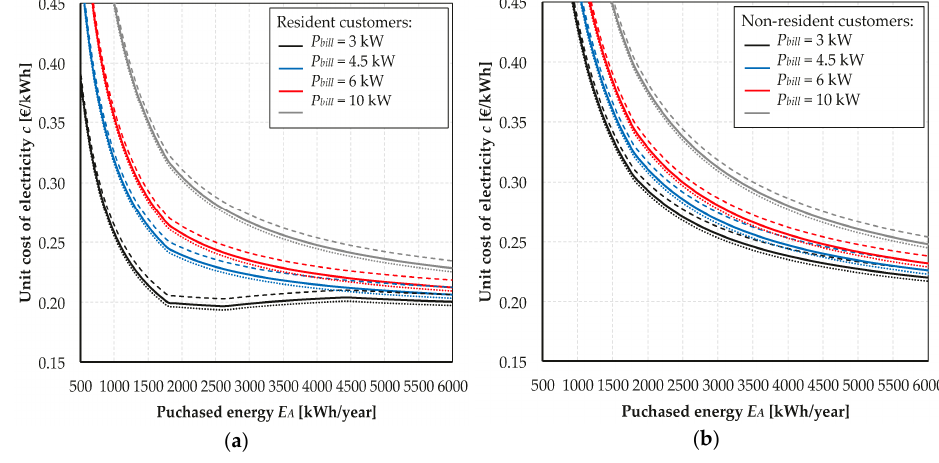
Figure 3. Correlation between the yearly absorption E A and the electricity unit cost c = C/E A , with contractual power P bill equal to 3 kW, 4.5 kW, 6 kW, and 10 kW. ( a ) Resident customers; ( b ) Non-resident end-users. In both the figures, continuous lines represent the electricity unit cost adopting the ECP pricing method, whereas dotted lines and dashed lines refer to the TOU pricing mechanism (considering E A 1 / E A = 0 and E A 1 / E A = 1, respectively). Table 4. Coefficients for the computation of the customer bill (values are defined by the Italian national authority and are updated to the third quarter of 2017).